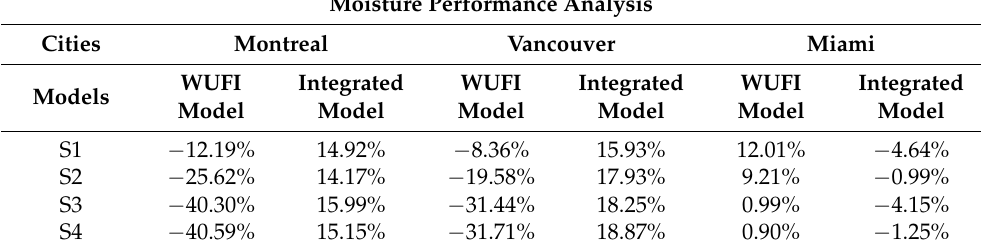
Table 8. Moisture performance analysis results by comparison of average percentage difference of simulated hourly relative humidity (RH) with ASHRAE Standard 160 level between WUFI and the integrated